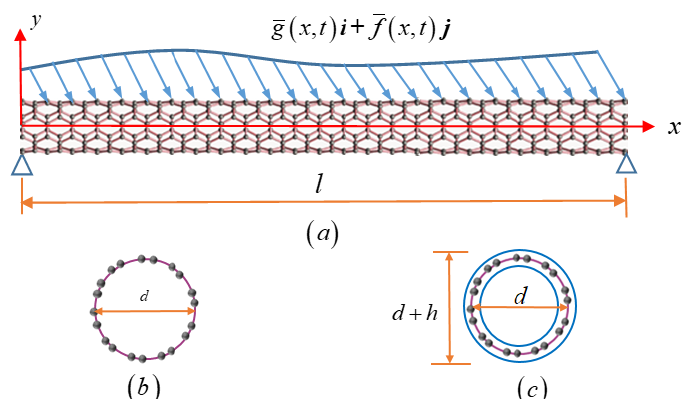
Figure 1. Schematic configuration of a single-walled carbon nanotube (SWCNT). ( a ) Front elevation, ( b ) Plan, ( c ) Equivalent cross-section. ( b ) Plan, ( c ) Equivalent